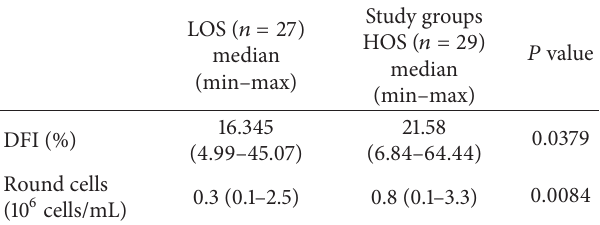
Table 2: Summary statistics of DFI and round cells concentration related to OS